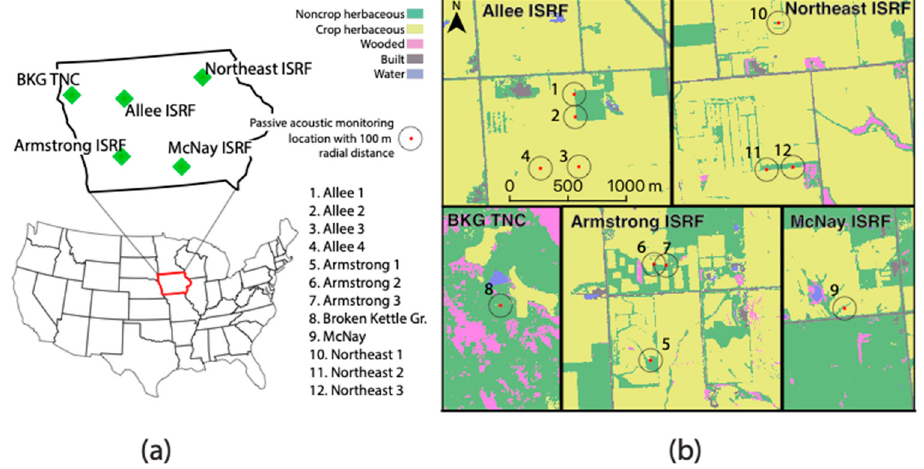
Figure 1. The study area ( a ) consisted of five sites across Iowa, USA. Passive acoustic monitoring locations (N = 12) are shown with land cover classification ( b ) in the background developed using PlanetScope (PS) imagery. Research and Demonstration Farms (ISRF) are managed through Iowa State University. Broken Kettle Grasslands (BKG) is a grassland preserve managed by The Nature Conservancy (TNC).